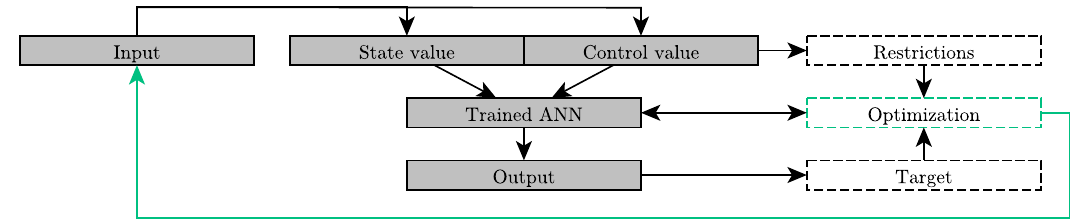
Figure 13. Basic application scheme of a (global) particle swarm optimization